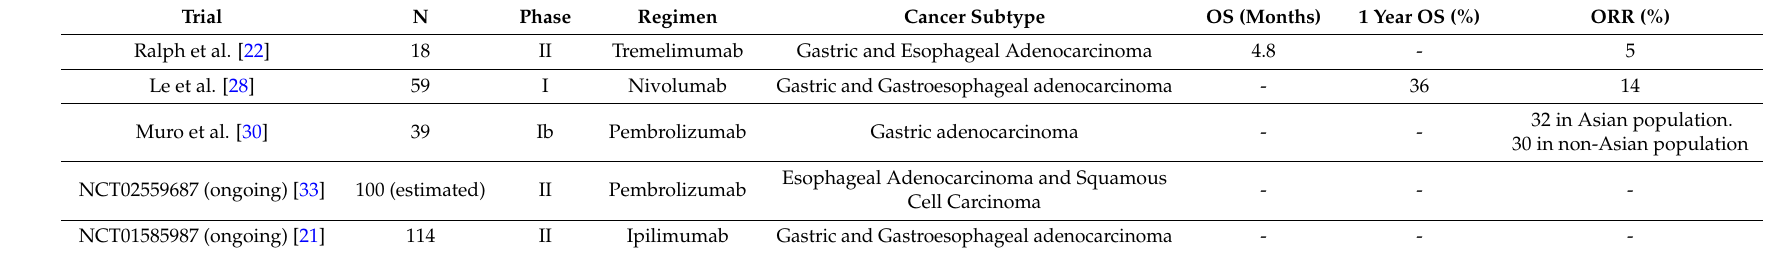
Table 1. Completed and ongoing trials (Phase I–III) investigating immune therapy in esophageal, HNSCC, and gastric